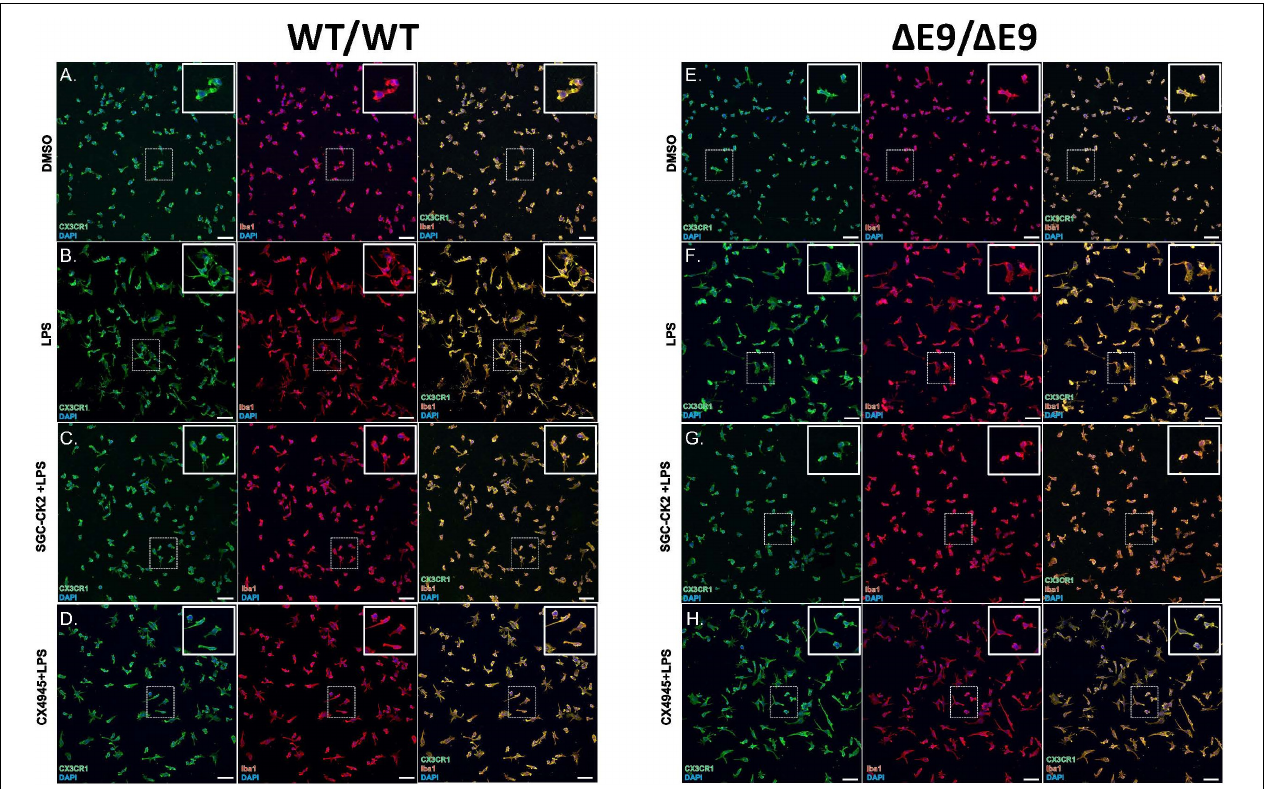
FIGURE 4 | Characterization of DMSO, LPS and drug treated MGLs derived from WT/WT and (cid:49) E9/ (cid:49) E9 (FAD) iPSCs. WT (A–D) and FAD (E–H) MGLs were stimulated with LPS (B,F) and simultaneously treated with either SGC-CK2-1 (C,G) or CX-4945 (D,H) for 24 h and immunocytochemistry was performed. In all conditions, MGLs robustly express microglia specific markers, CX3CR1 and Iba1. Scale bar = 50 µ